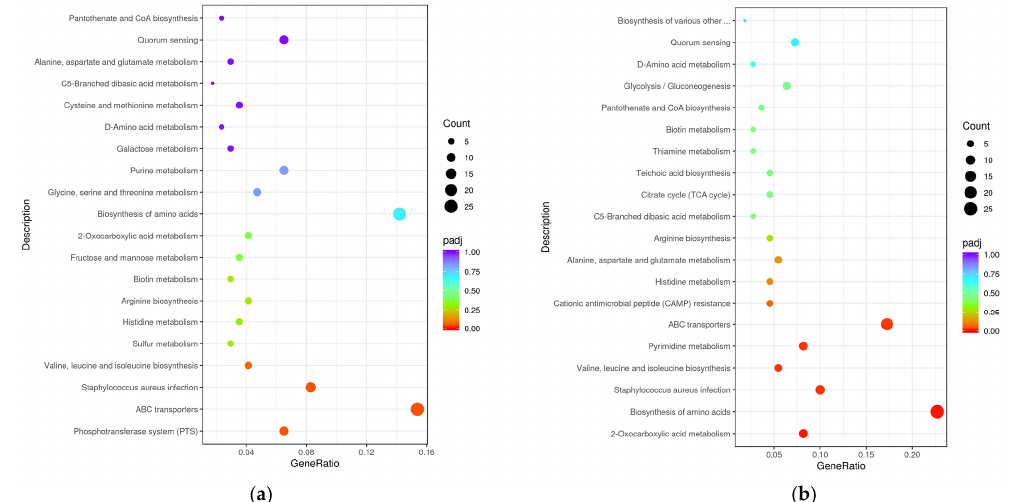
Figure 6. KEGG pathway enrichment analysis of DEGs with the treatment of chlorine-containing disinfectant. ( a ) KEGG pathway enrichment analysis of DEGs in ATCC 6538. ( b ) KEGG pathway enrichment analysis of DEGs in CHPC 1.8487. The bubble size indicates the number of genes, and the color shade represents the adjusted p value.